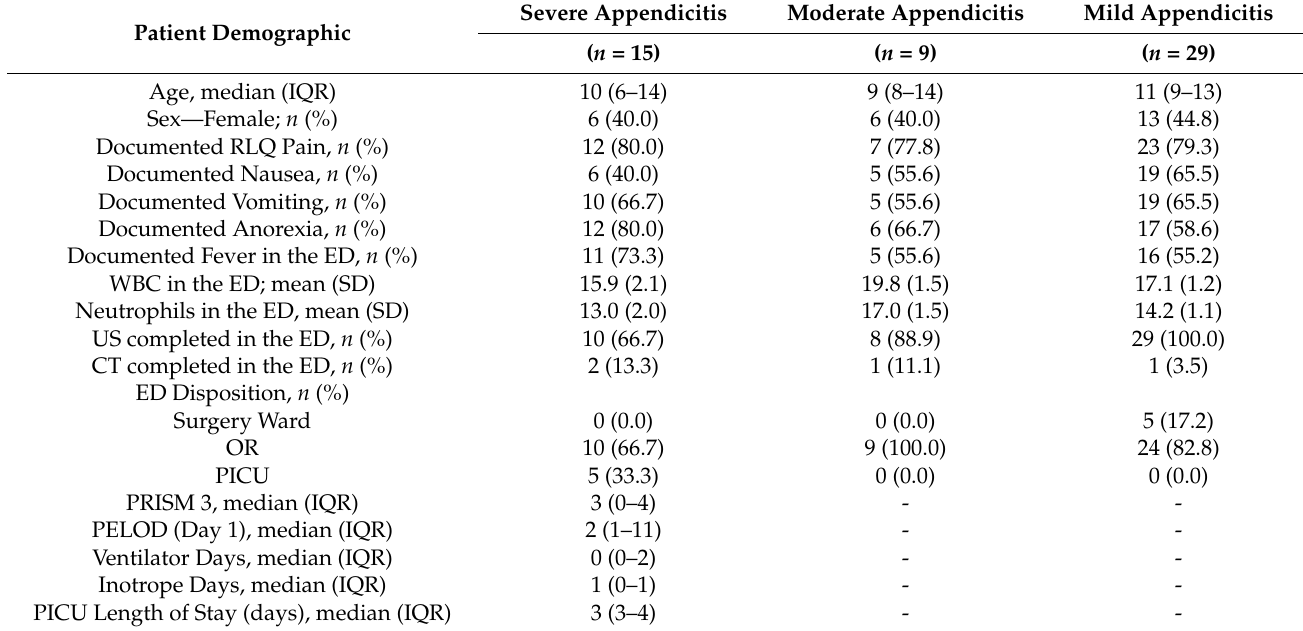
Table 1. Demographics of children presenting with severe, moderate and mild